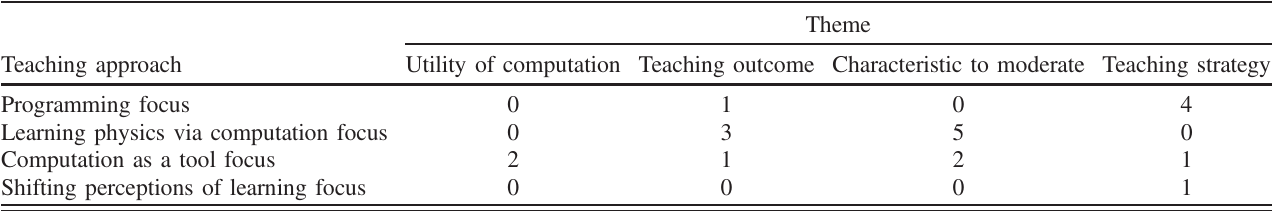
TABLE XII. Analysis of Kendra ’ s teaching approach. The numbers indicate the amount of statements Kendra made aligned with each teaching approach, within each theme. For example, Kendra made five statements total within the teaching outcome theme. One was aligned with a programming focus, one was aligned with a computation as a tool focus, and three were aligned with a learning physics via computation focus.